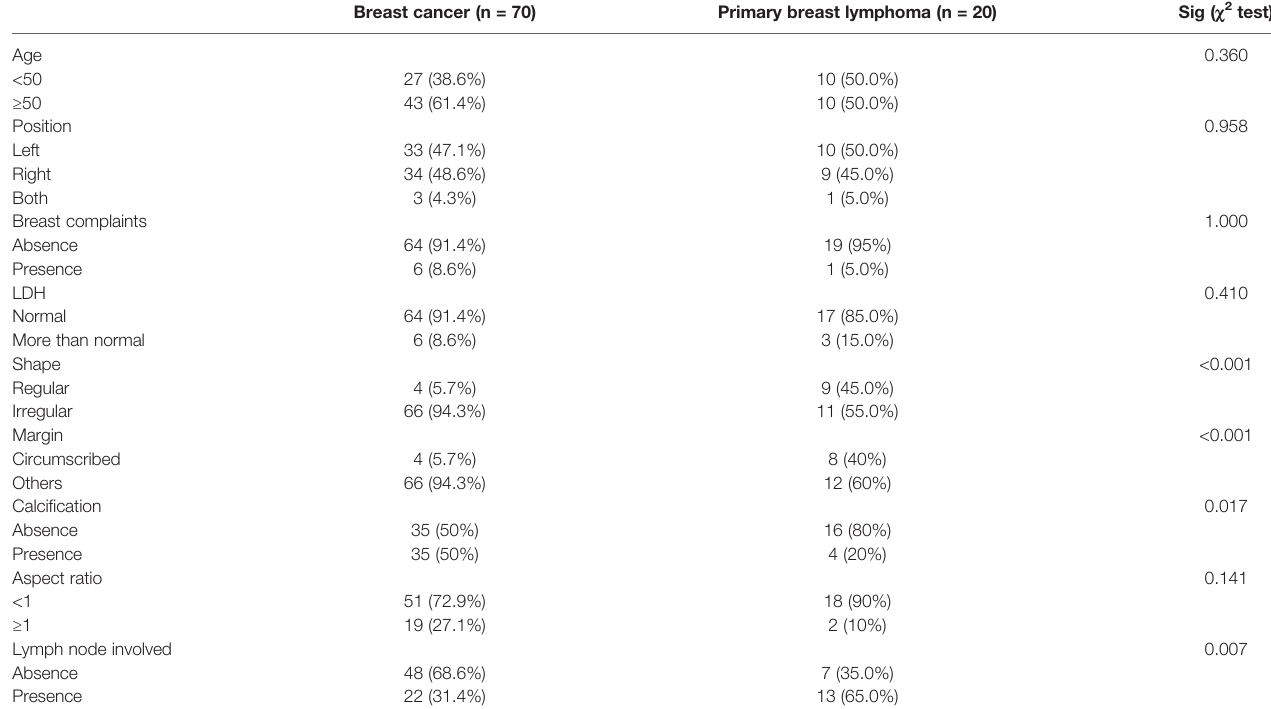
TABLE 1 | Clinical and image characteristics between breast cancer and primary breast